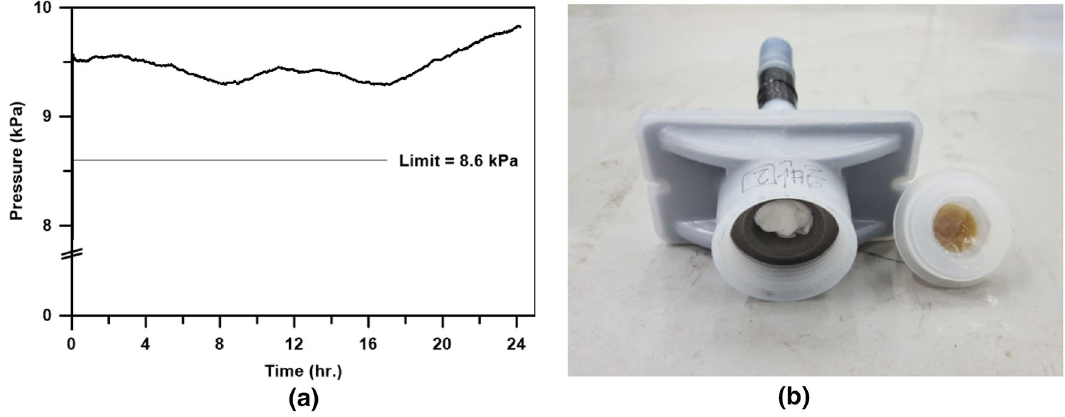
Fig. 11 Results of hydrostatic tests. a Pressure over time and b photo taken after hydrostatic test.